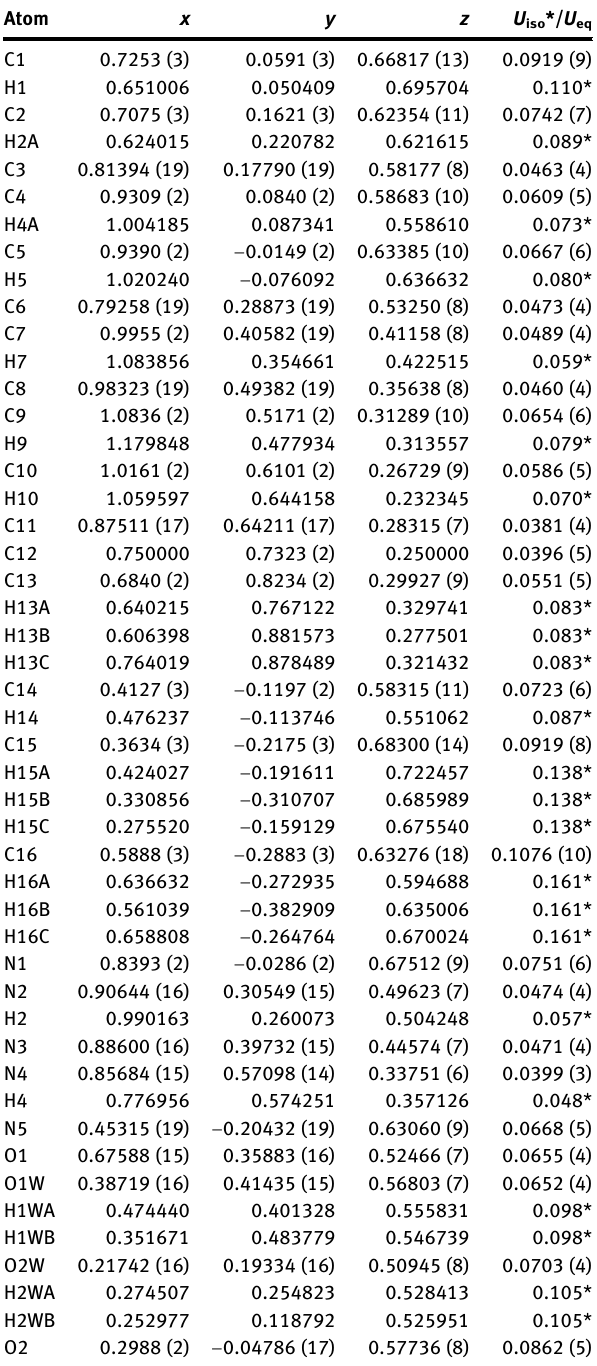
Table  : Fractional atomic coordinates and isotropic or equivalent isotropic displacement parameters (Å 